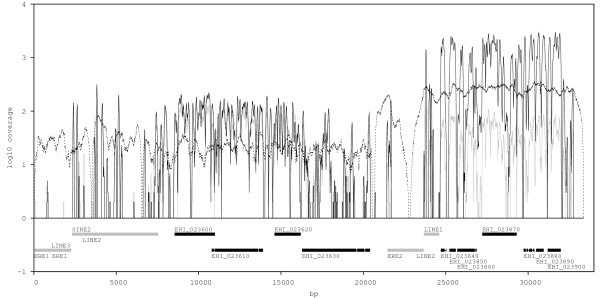
Segmental duplication in the E. histolytica Rahman strain. High coverage across a region of scaffold DS571330 in the Rahman genome is confirmed by independently generated sequencing libraries (SOLiD and 454). The region encompasses seven genes and is flanked by repetitive elements. The black line represents coverage from Rahman SOLiD sequencing library, the dashed line represents coverage from Rahman 454 sequencing library, the grey line represents coverage from strain HM-1B SOLiD sequencing library, and is shown as a control. Coverage depth is displayed on a log scale in order to show both SOLiD and 454 data (where many fewer reads are generated) on the same plot.